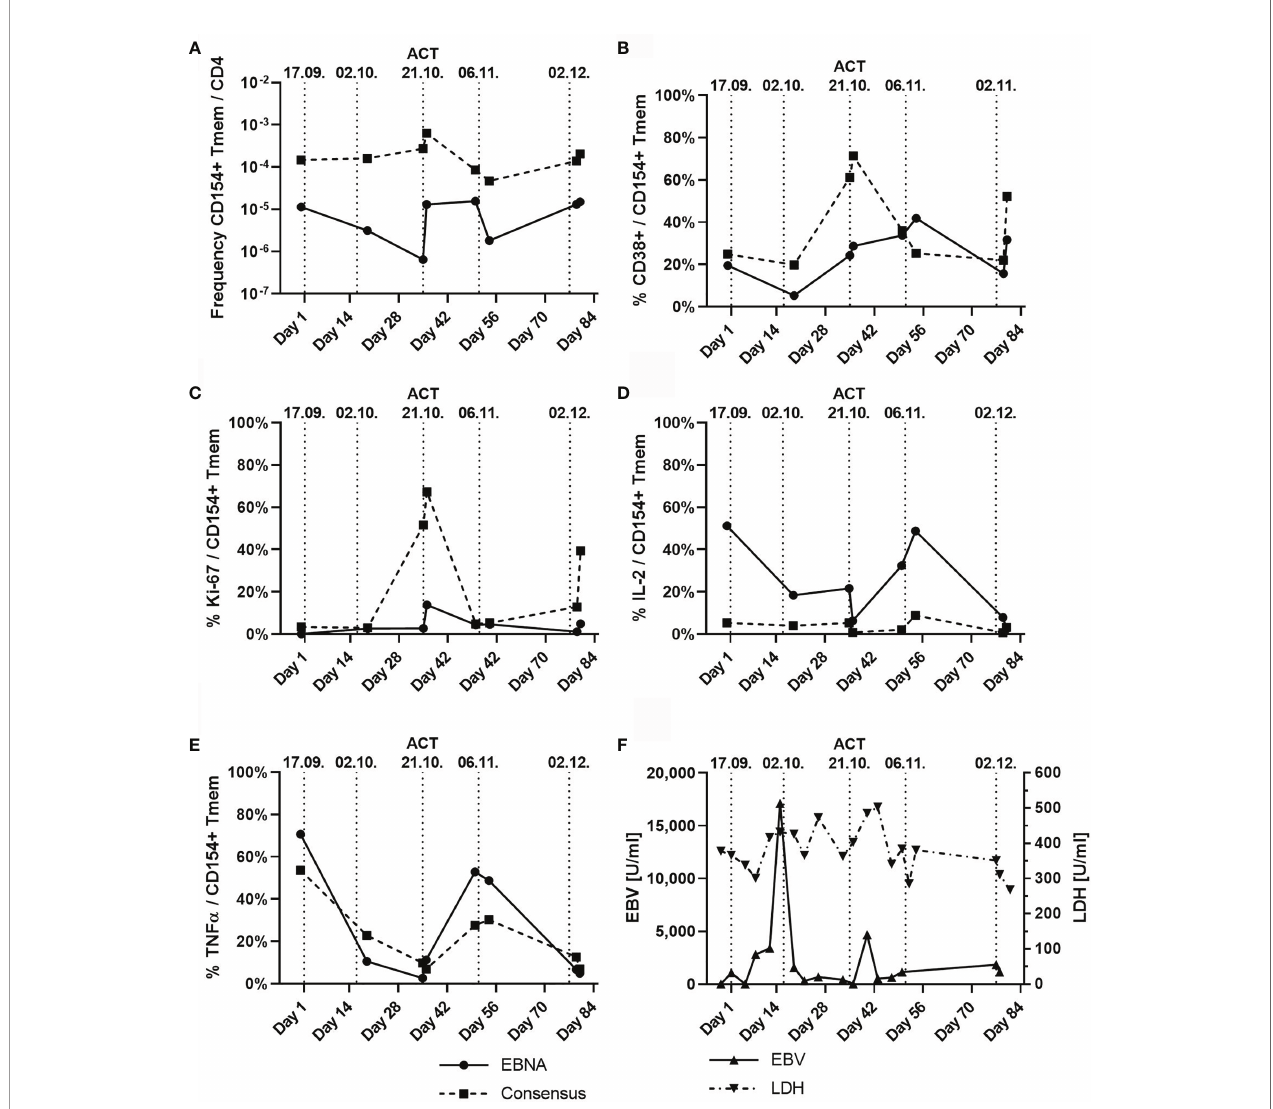
FIGURE 3 | T-cell subpopulations and dynamic of Epstein – Barr virus (EBV) viremia and lactate dehydrogenase (LDH) during the course of fi ve adoptive cell transfers (ACTs), indicated by vertical dotted lines. (A) Frequency of CD154 + (CD40L + ) memory T cells (T mem ) normalized to the count of CD4 + T cells with speci fi city to either EBNA (solid line) or EBV consensus antigens (dotted line). (B) Percentage of CD38 + T cells among CD154 + (CD40L + ) T mem cells depicted in panel (A) . (C) Percentage of Ki-67-expressing T cells among CD154 + (CD40L + ) T mem cells. (D) Percentage of Interleukin 2 (IL-2)-expressing T cells among CD154 + (CD40L + ) T mem cells. (E) Percentage of tumor necrosis factor alpha (TNF- a )-expressing T cells among CD154 + (CD40L + ) T mem cells. (F) Serum levels of EBV (U/ml) and LDH (U/ml). Remarks: Graphs in panels (A – E) are given for EBNA-1-speci fi c T cells and T cells reactive against the EBV consensus pool of